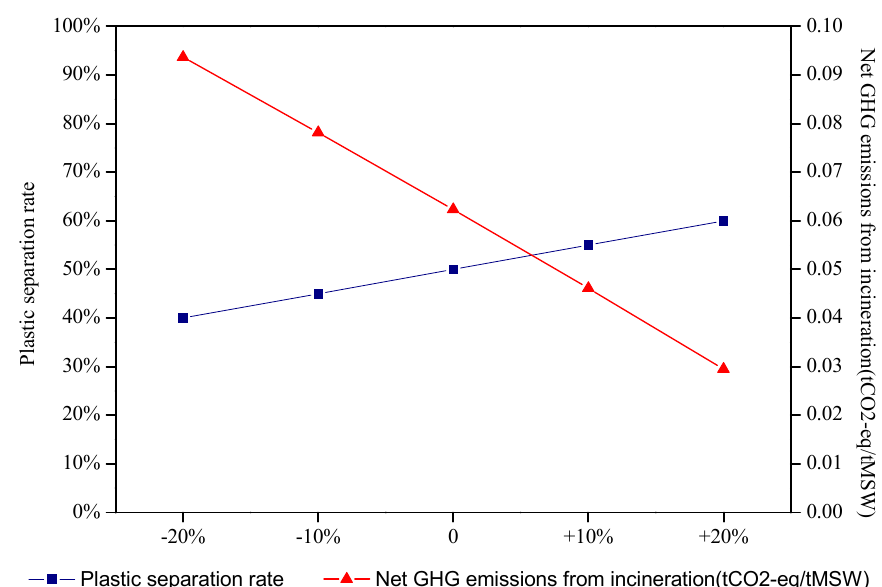
Figure 9. The relationship between plastic separation rate and net GHG emissions from incineration.